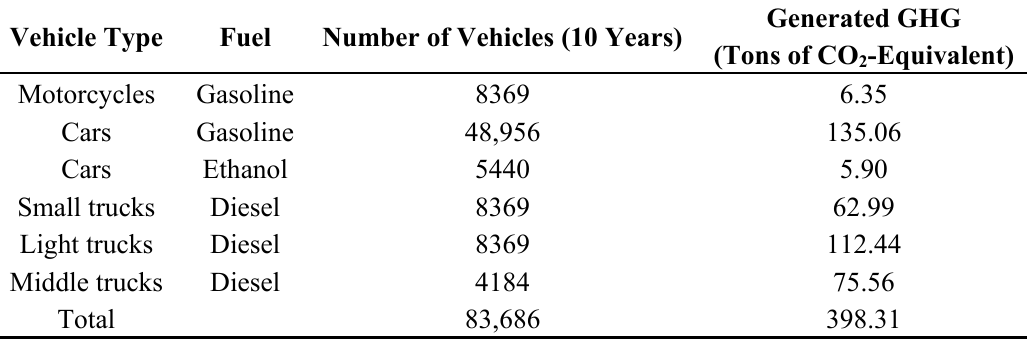
Table 2. GHG emission due the road operation for a 10 year period.